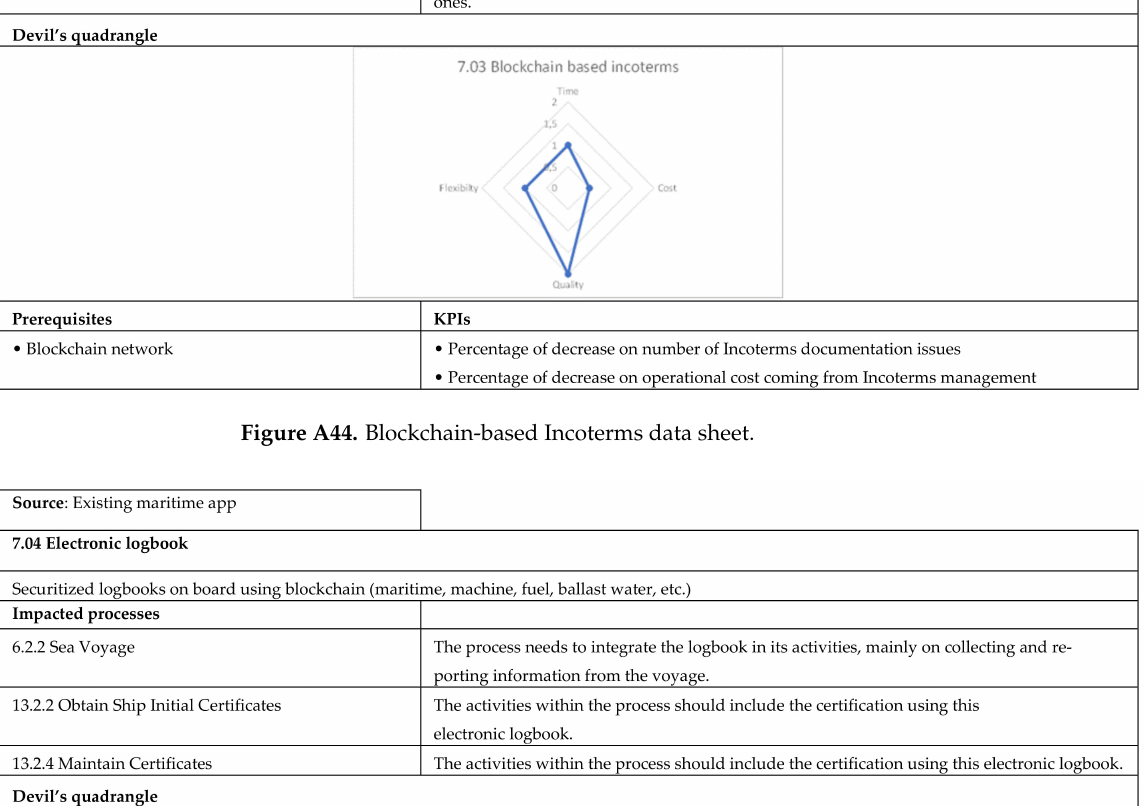
Figure A45. Cont